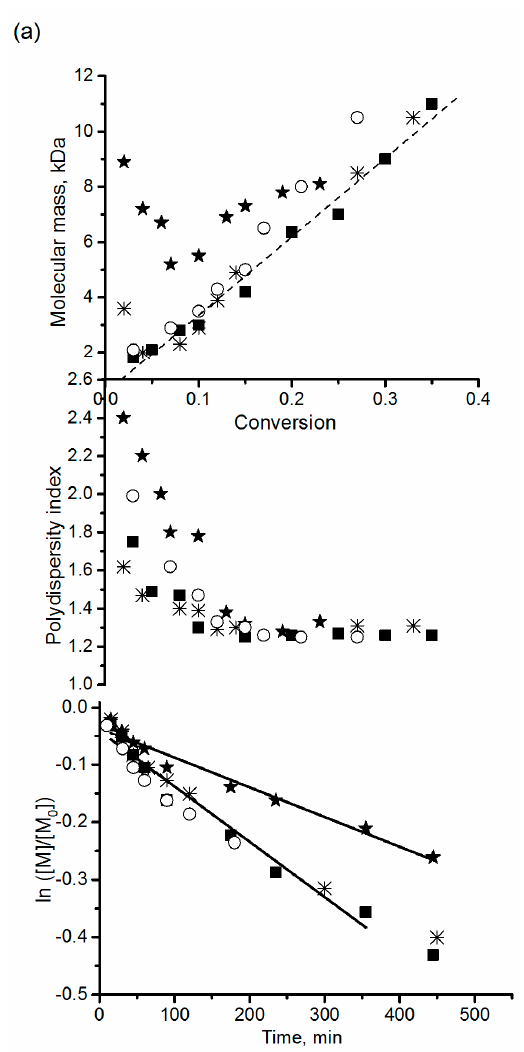
Figure 11. M n versus conversion, PDI vs. conversion, and ln([M]/[M] 0 ) vs. time plots for (a) the polymerization of styrene at 90 ◦ C initiated with RS/SR - 3 ( (cid:70) ), Zn- RSSR - 3 ( (cid:4) ), Zn- RSSR - 3’ ( RS/SR - 3 + 0.5 eq. Zn(hfac) 2 ) ( * ), or 3 + 10 eq. Zn(hfac) 2 ( ○ ); the monomer to initiator ratio is 250:1.